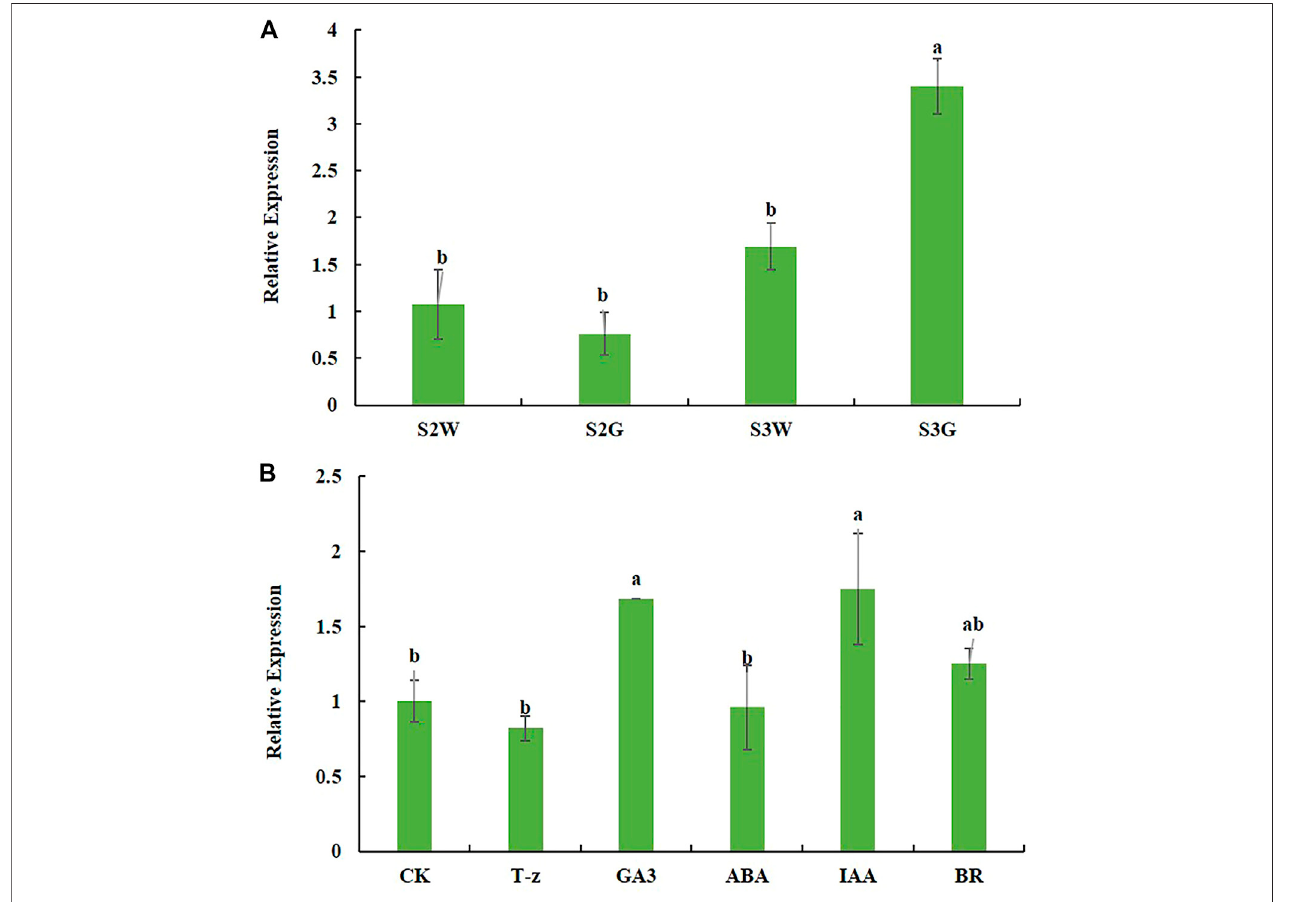
FIGURE6 | Expression pro fi le of AbGLK1 during chimericleaf development (A) and response tohormonestimuli (B) . S2W and S3W mean white parts ofchimeric leaves at S2 and S3, respectively. S2G and S3G mean green parts of chimeric leaves at S2 and S3, respectively. CK, T-z, ABA, IAA, BR mean tissue culture plantlets treated hormone treatments, respectively. Error bars for RT-qPCR show the standard deviation of three replicates. Different lowercase letters indicate signi fi cant differences at the 0.05 level.